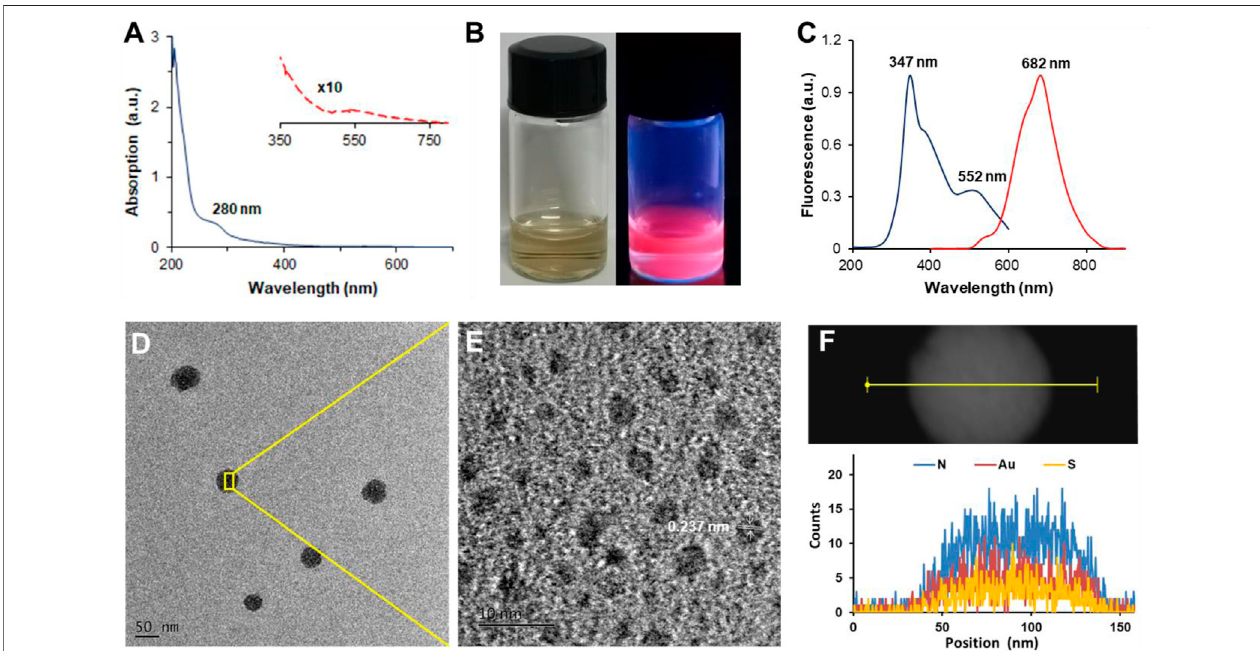
FIGURE2| UV-visiblespectrumofLGNCs (A) .Thereddashedlineistheenlargedviewof350 – 750 nm.ThephotographofLGNCsunderwhitelight(left)and365- nm hand-held UV lamp excitation (right) (B) . Photoemission (red line) and photoexcitation (blue line) spectra of LGNCs (C) . High-resolution transmission electron microscopy (HRTEM) images of LGNC aggregates (D) and embedded individual LGNC (E) . The distribution of elements inside a single LGNC aggregate detected by energy-dispersive X-ray spectroscopy (EDS) (F) .